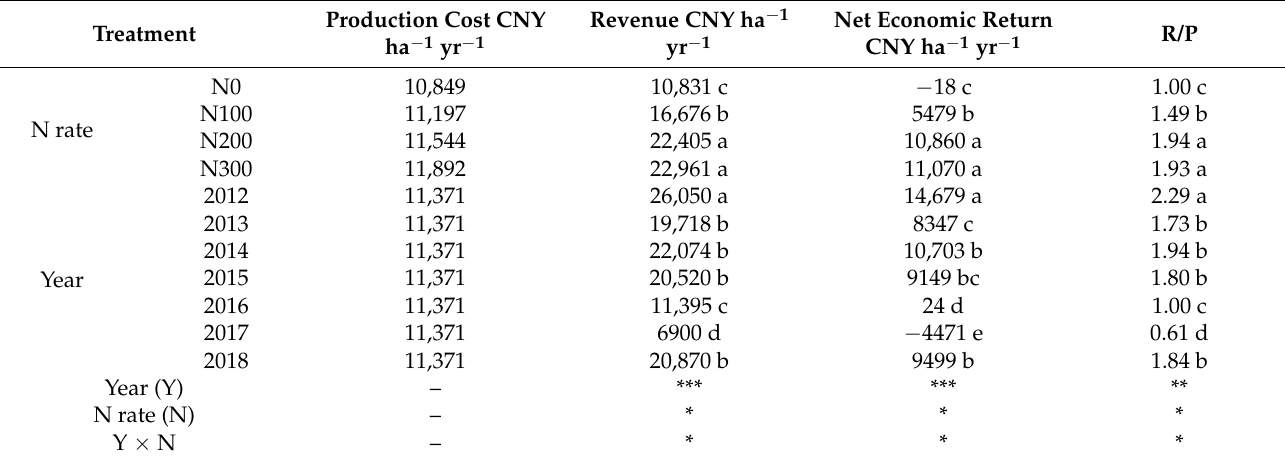
Table 5. Effects of four rates of nitrogen (N) application and growing seasons on production cost, revenue, net economic return, and ratio of revenue-to-production cost (R/P) of